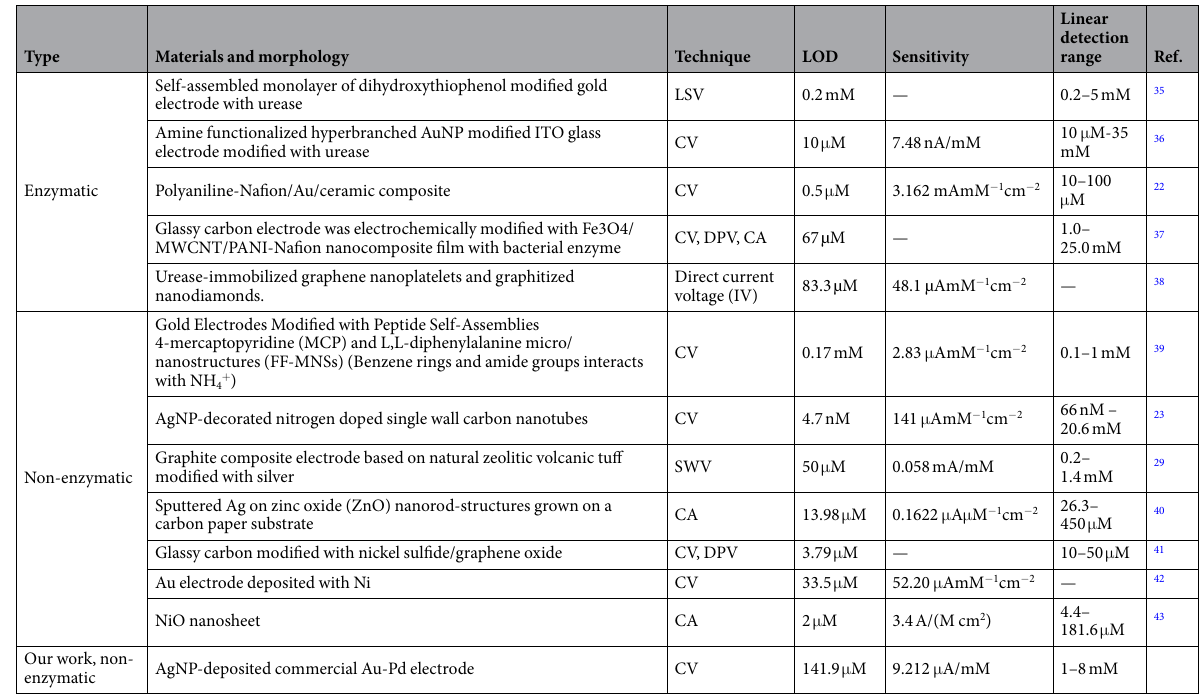
Table 1. Comparison of electrochemical electrodes reported in the literature for urea